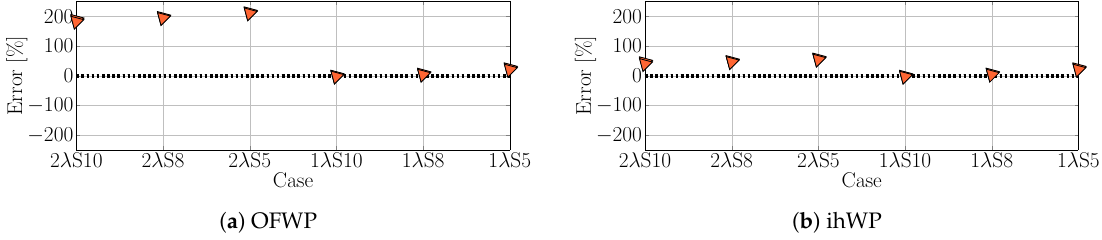
σ (cid:101) for different NB settings (length and damping factor) based on free Figure A5. Error (cid:101) ¯ H msw ± ¯ Hmsw surface elevation data extracted with the ihWP and